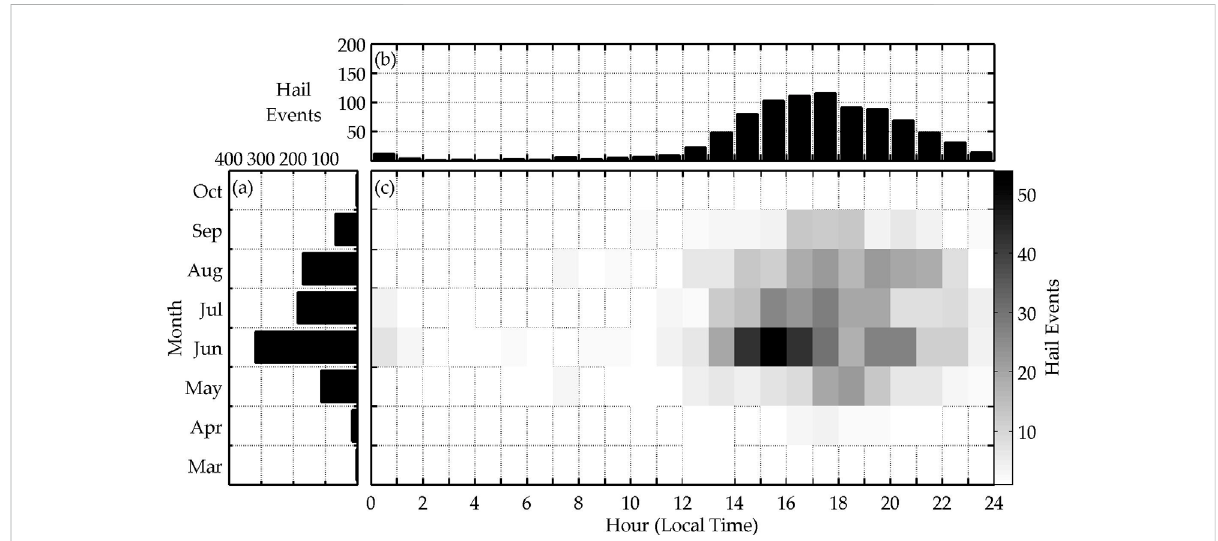
FIGURE 3 SeasonalanddiurnalcyclesofhaileventsinBeijingfrom1980to2021: (A) .Averagedseasonalcycleofhailevents; (B) .Averageddiurnalcycleof hail events; (C) . Mean hail events against months and